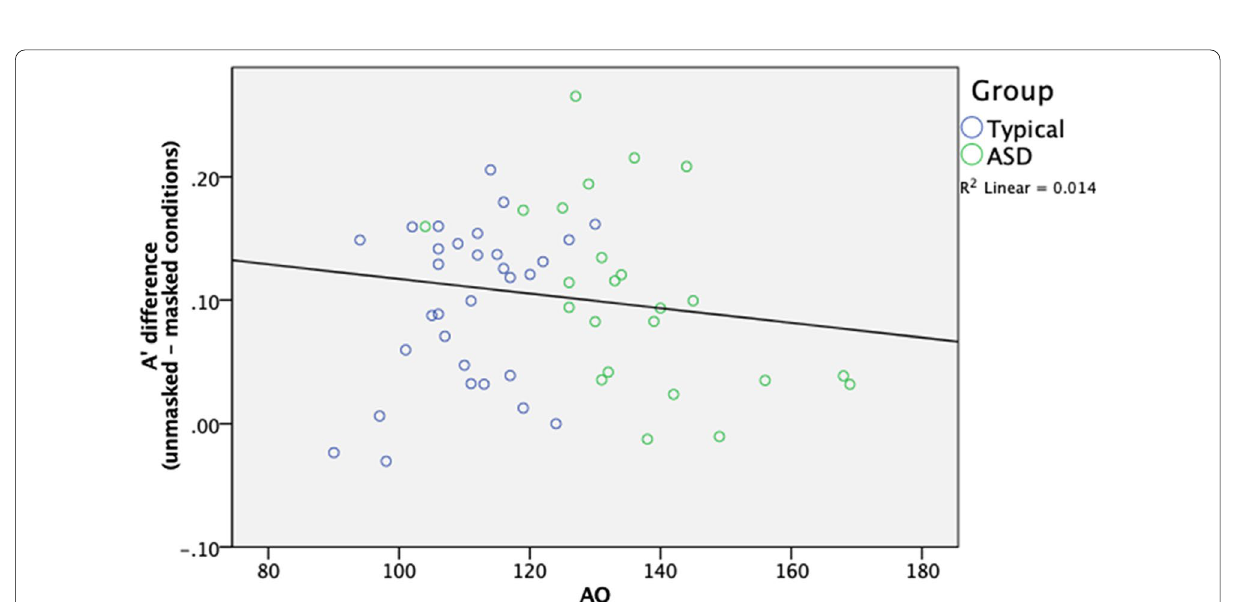
Fig. 3 Correlations between A’ difference between the unmasked and masked conditions and